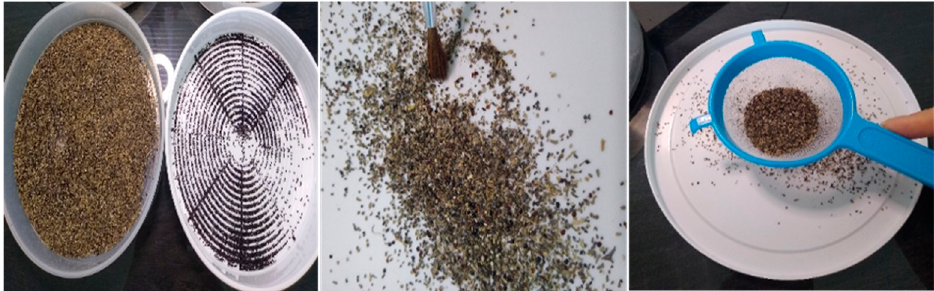
Figure 2. Procedure for cleaning S. edulis seeds from the harvested biomass and field residues.